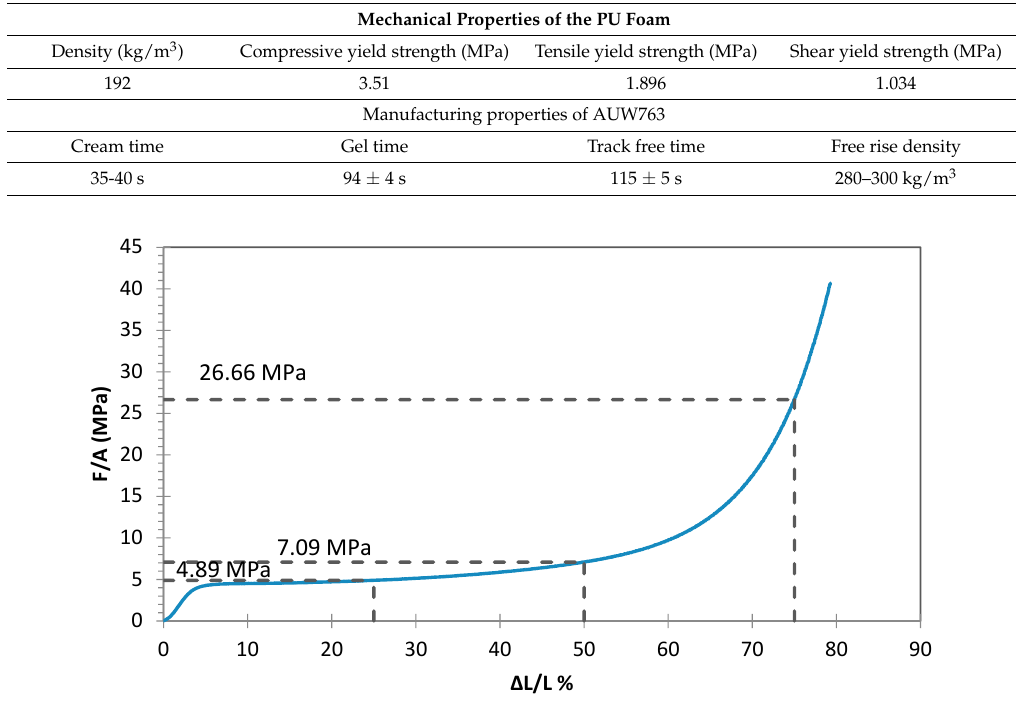
Table 1. Mechanical and manufacturing properties of the selected PU rigid foam.